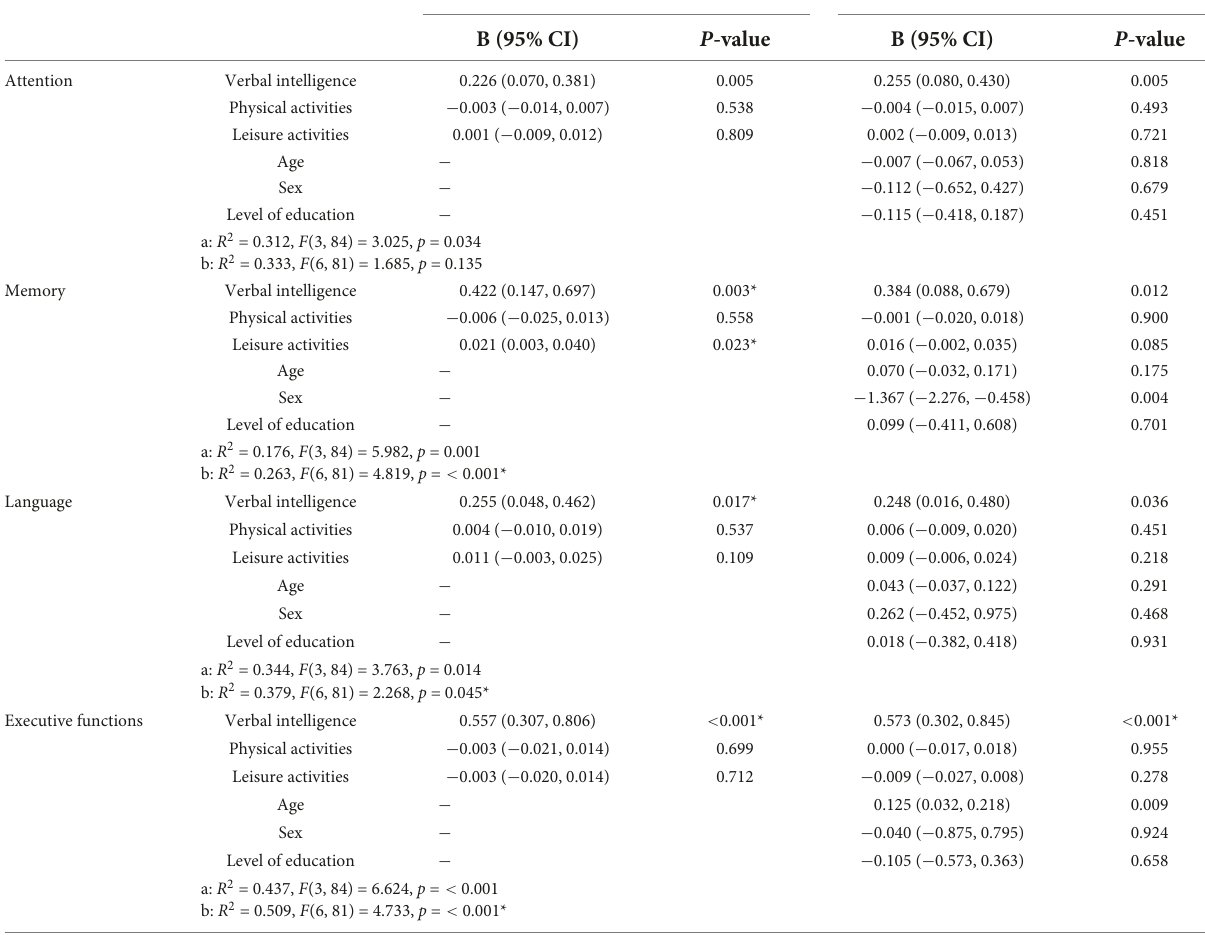
TABLE 3 Multiple linear regression analysis with NEUROPSI cognitive processes as